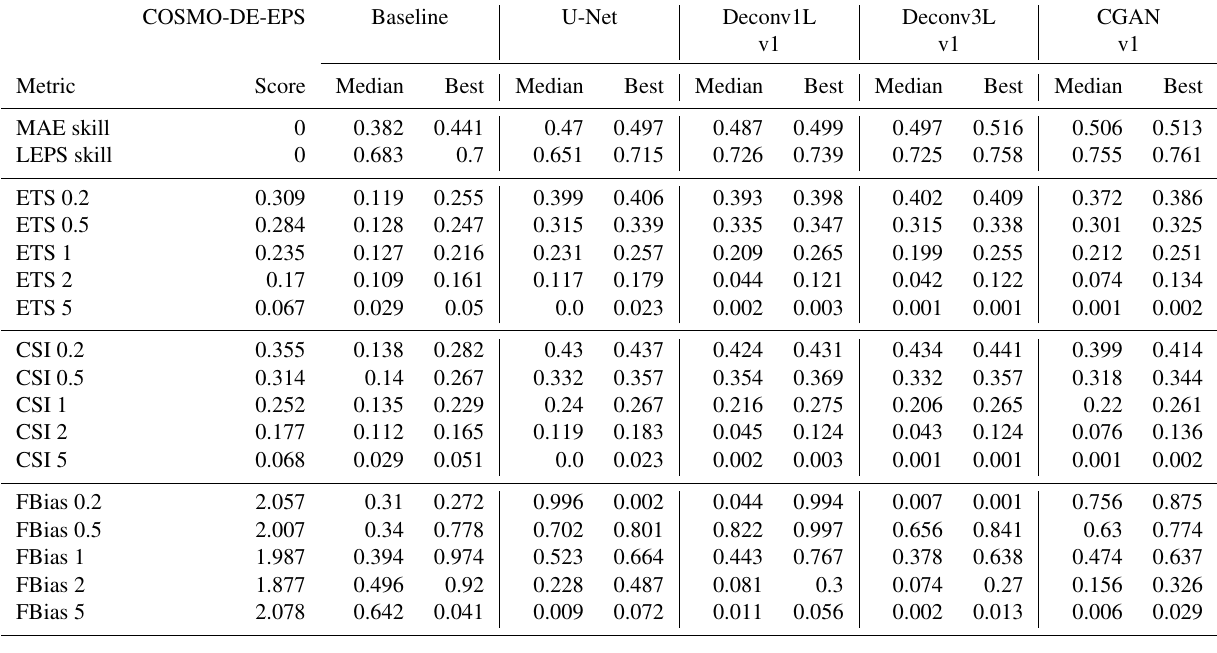
Table 2. Summary of the results: median and best-performing model are presented for each of the metrics.